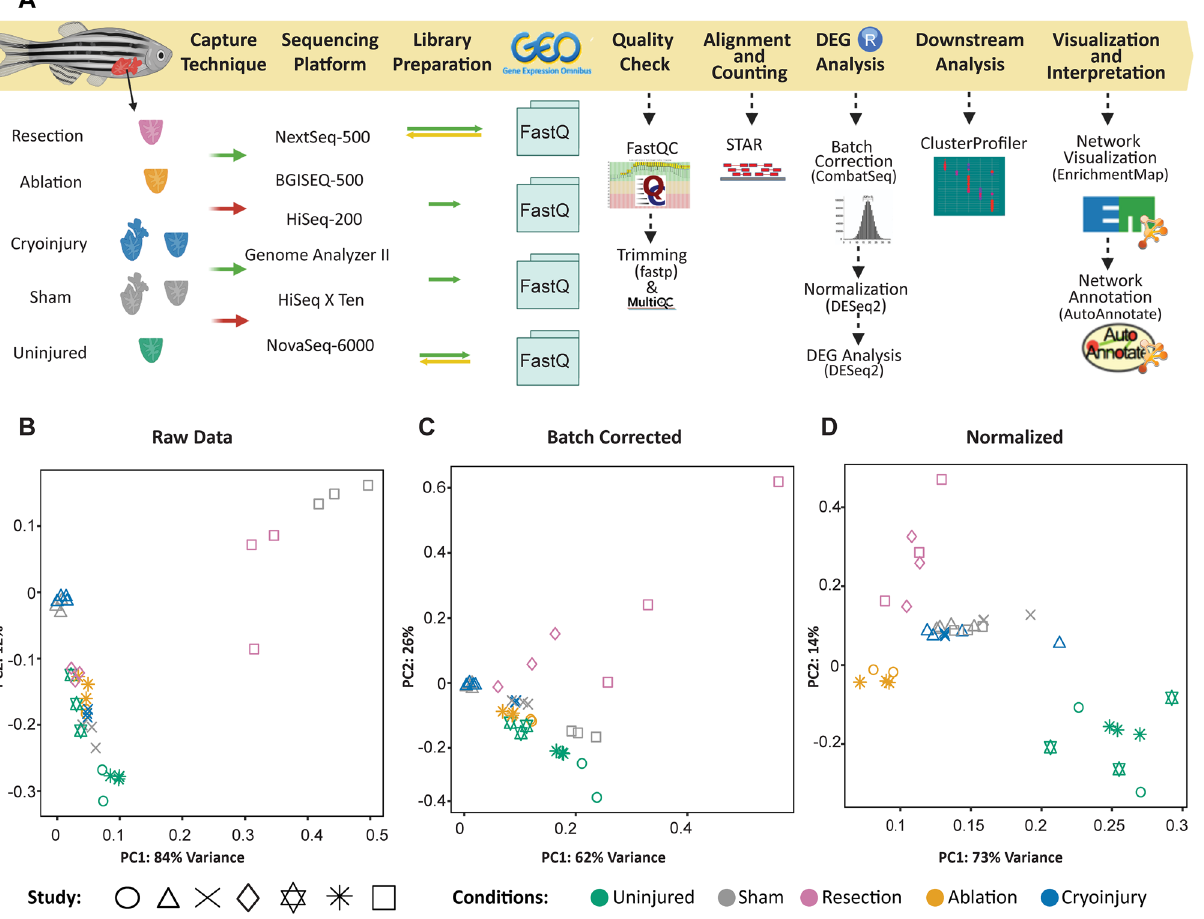
Figure 1. Transcriptomic meta-analysis of the cardiac regenerative response upon distinct types of injuries. ( A ) Workflow of the process used to analyze the data. Selected datasets differed in conditions of the transcriptomic data such as the capture techniques, sequencing platforms and reads structure. Data were downloaded from GEO and the processing steps to find the differentially expressed genes were performed. This was followed by downstream analysis to interpret the results. ( B ) PCA plots of the raw data before any processing. ( C ) Batch corrected, after removing the platform sequencing variable giving the highest batch effect. ( D ) DESeq2 normalized